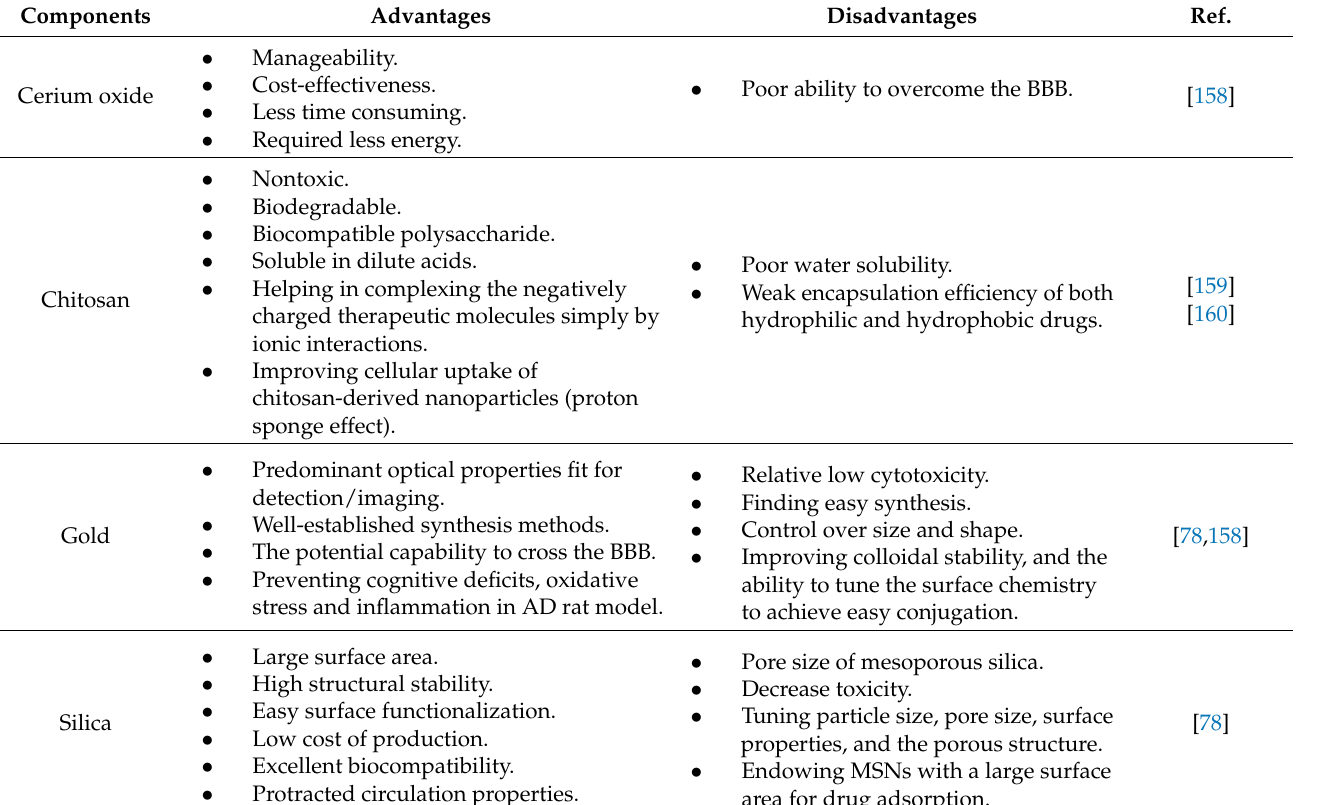
Table 1. The advantages and disadvantages of the common nanoparticles in brain delivery. Components Advantages Disadvantages Ref.